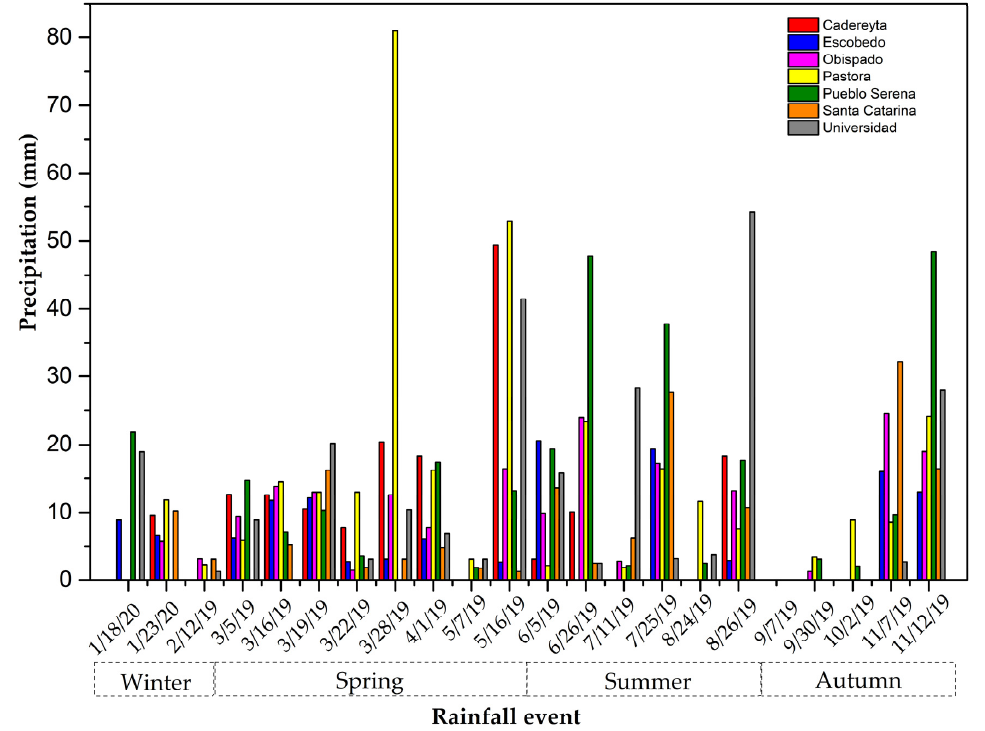
Figure 2. Precipitation amount for each rainfall event in all monitoring sites.